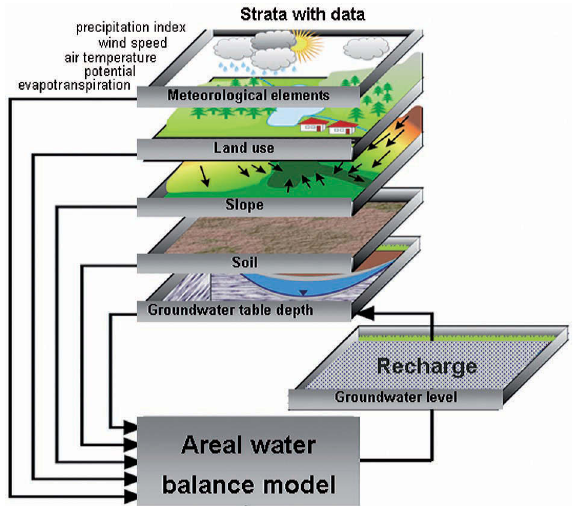
Fig. 2. Schematisation and integration of data for a hypo- thetical raster cell in the WetSpass water balance model, after Batelaan and De Smedt